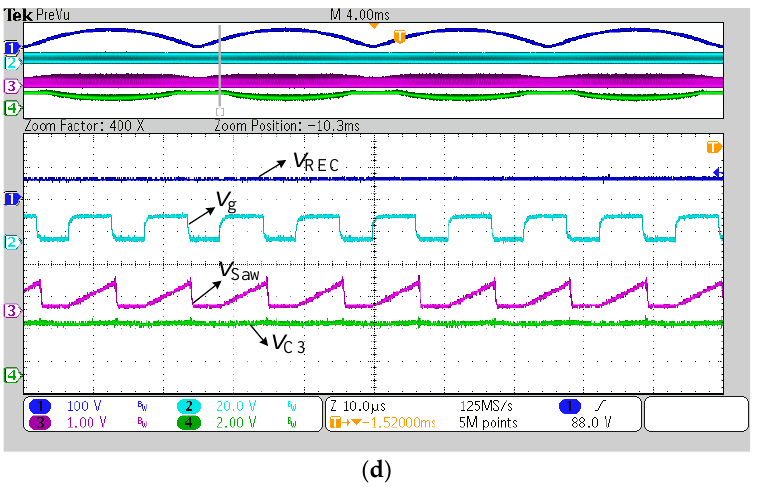
Figure 20. Experimental waveforms of v REC , v g , v Saw , and v C 3 of VOT control with 110 Vac input voltage and rated output current. ( a ) overall waveform; ( b ) zoom in waveform at ωt = π/2; ( c ) zoom in waveform at 120 V transient rectified input voltage; ( d ) zoom in waveform near zero-cross point of input voltage.